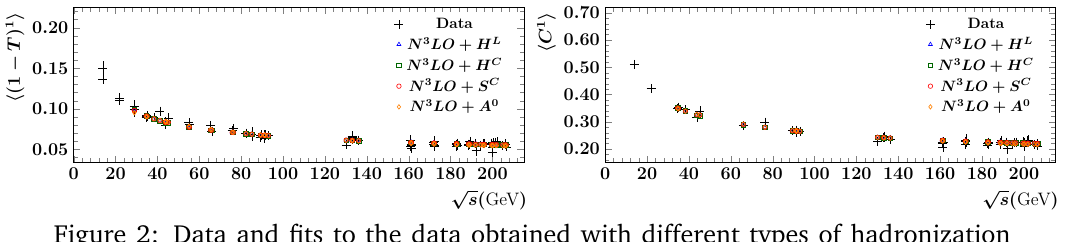
Figure 2: Data and fits to the data obtained with different types of hadronization models. Figures from Ref. [ 4 ]